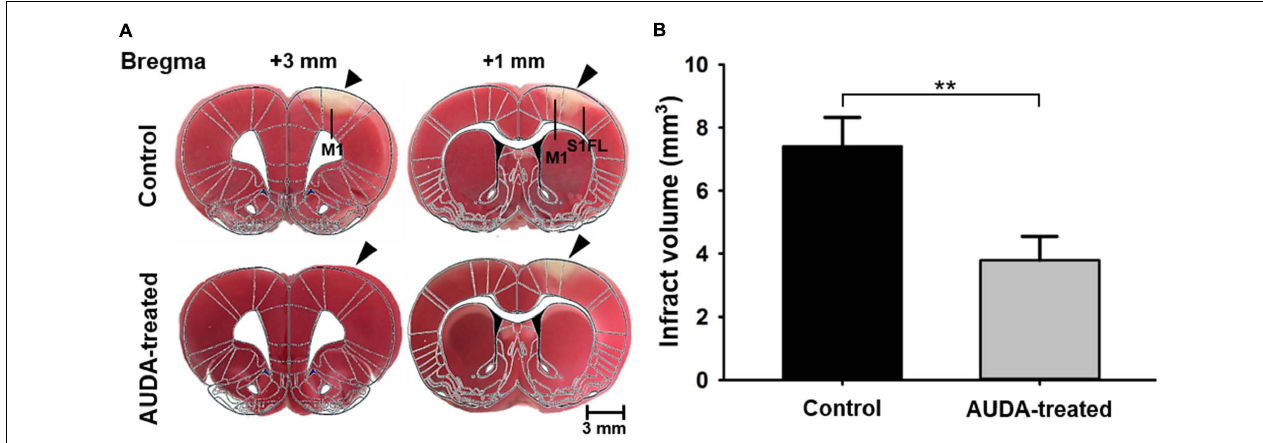
FIGURE 8 | Comparison of infarct volume 7 days after PTI stroke. Analysis and quantification of infarct volume by TTC staining. (A) Coronal sections of ischemic rat brain at 1 and 3 mm anterior to the bregma. The red area is the normal area, and the light colored area is the infarct area, indicated by black arrowheads. (B) Statistical analysis of infarct volume. The infarct volume in the AUDA-treated group was significantly decreased compared with the control group on post-PTI stroke day 7. The scale bar is 3 mm. The symbol “ ∗∗ ” indicated significant differences (** p < 0.01, Mann–Whitney U -test, N = 5 for each group). Data are presented as the mean ±